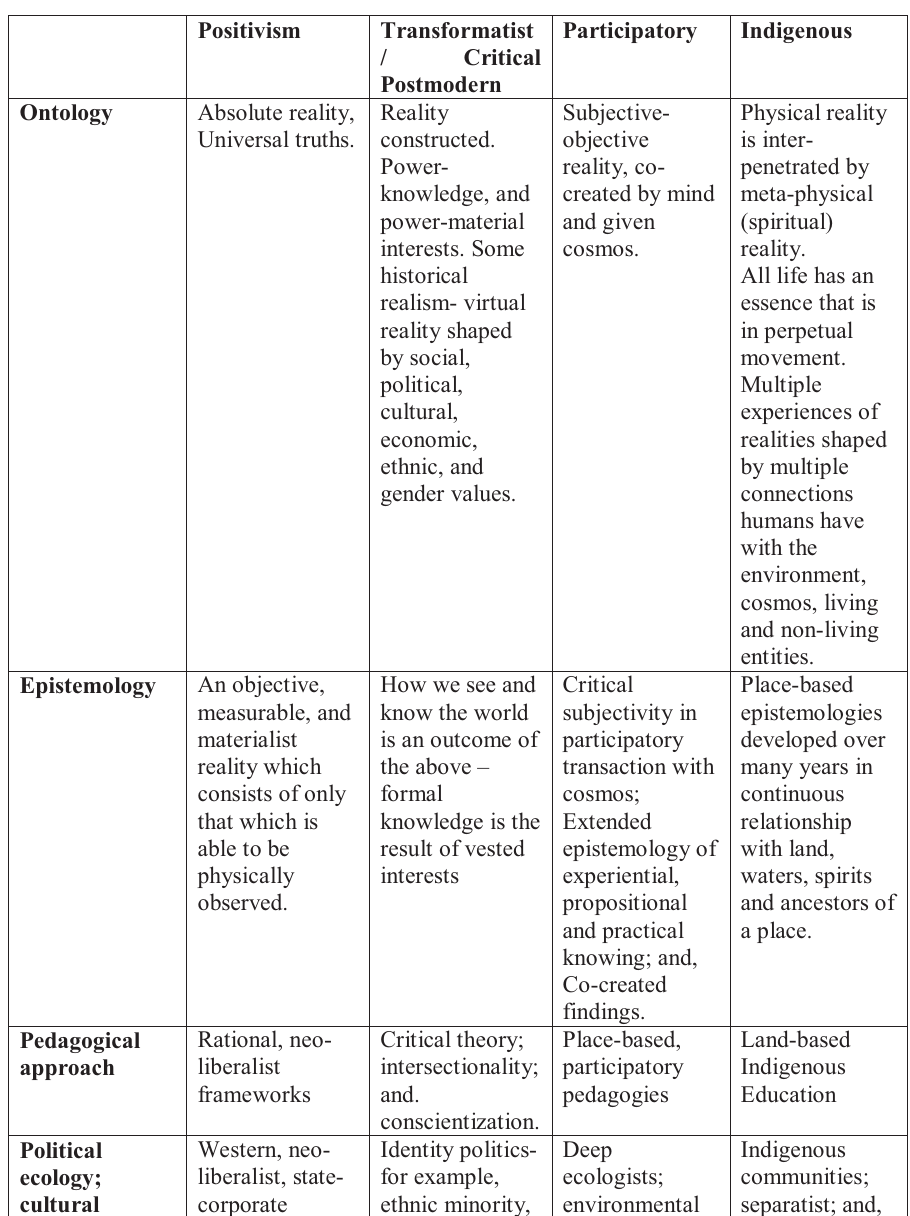
FIGURE 1 Four pedagogical paradigms for sustainability education (Adapted from four empowerment paradigms and the socio-ecological basis of health, Williams (2016a), pp. 9).